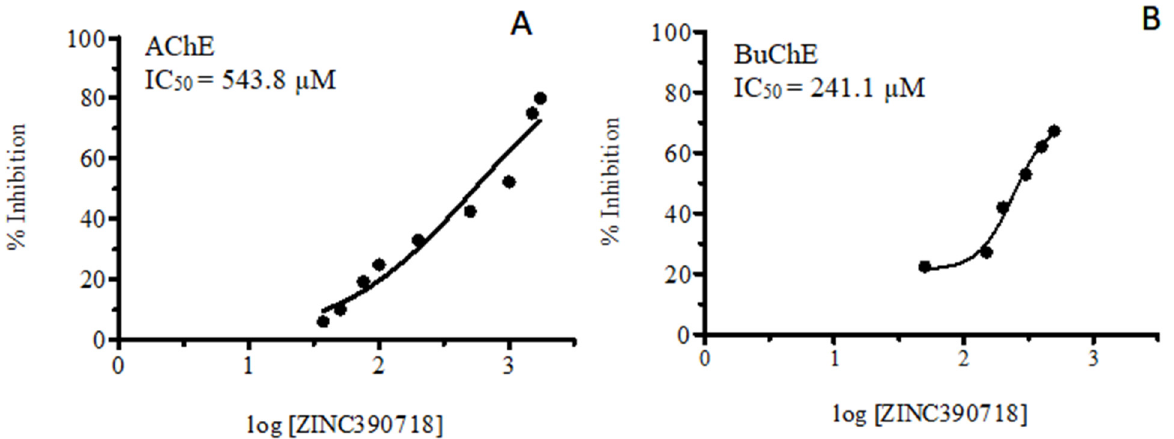
Figure 2. Concentration–response curve of the in vitro anticholinesterase effect of ZINC390718: ( A ) acetylcholinesterase (AChE) and ( B ) butyrylcholinesterase (BuChE).